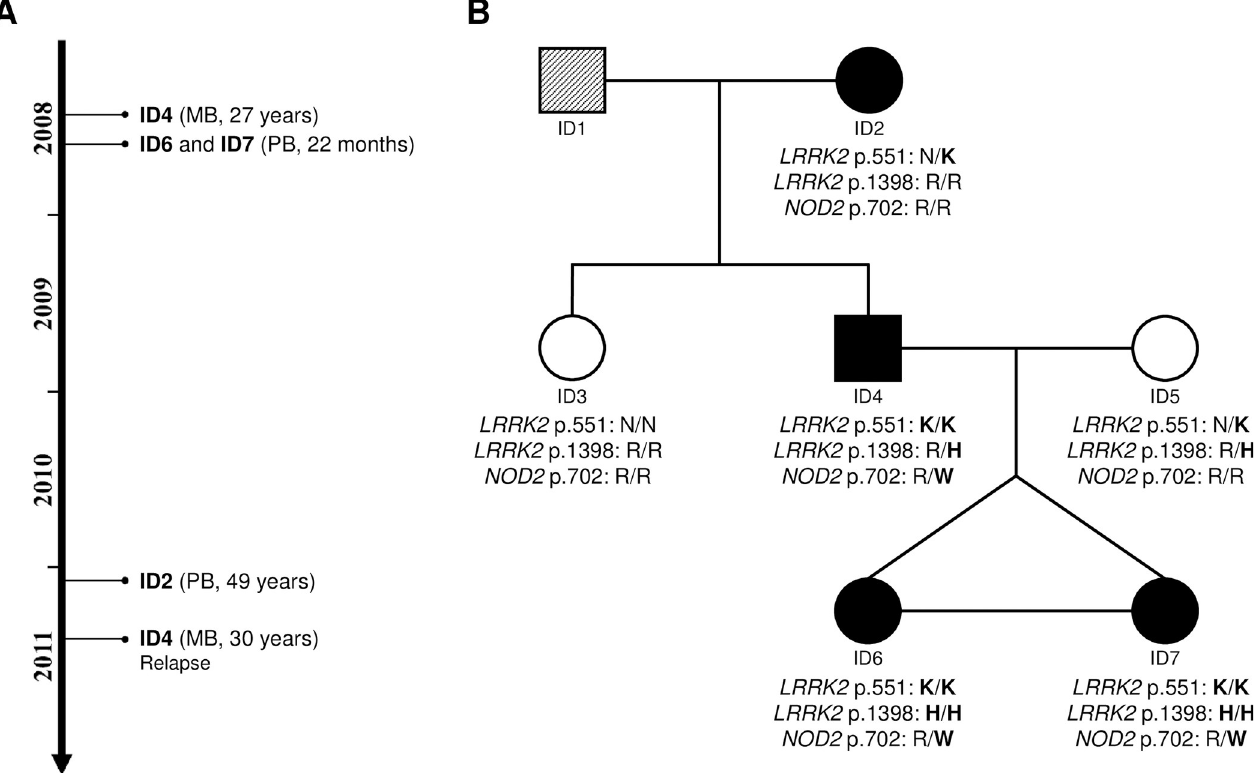
Fig 1. Missense variants in LRRK2 and NOD2 detected in a family with early onset leprosy in monozygotic twins. (A) Timeline of leprosy diagnosis among the affected family members, indicating the sample ID, leprosy subtype based on WHO classification and age-at-diagnosis. No patient developed leprosy reactions during treatment and a five-year follow-up. (B) Pedigree of the studied family indicating leprosy phenotype and genotypes of candidate variants LRRK2 N551K (rs7308720), LRRK2 R1398H (rs7133914), and NOD2 R702W (rs2066844) in individuals with whole genome sequencing (WGS) data. Men and women are represented by boxes and circles, respectively. Leprosy patients (regardless of the clinical subtype) are indicated by filled symbols, while an unknown phenotype is indicated by a symbol with diagonal stripes. Monozygosity is represented by a horizontal line linking siblings. PB: Paucibacillary; MB: Multibacillary.